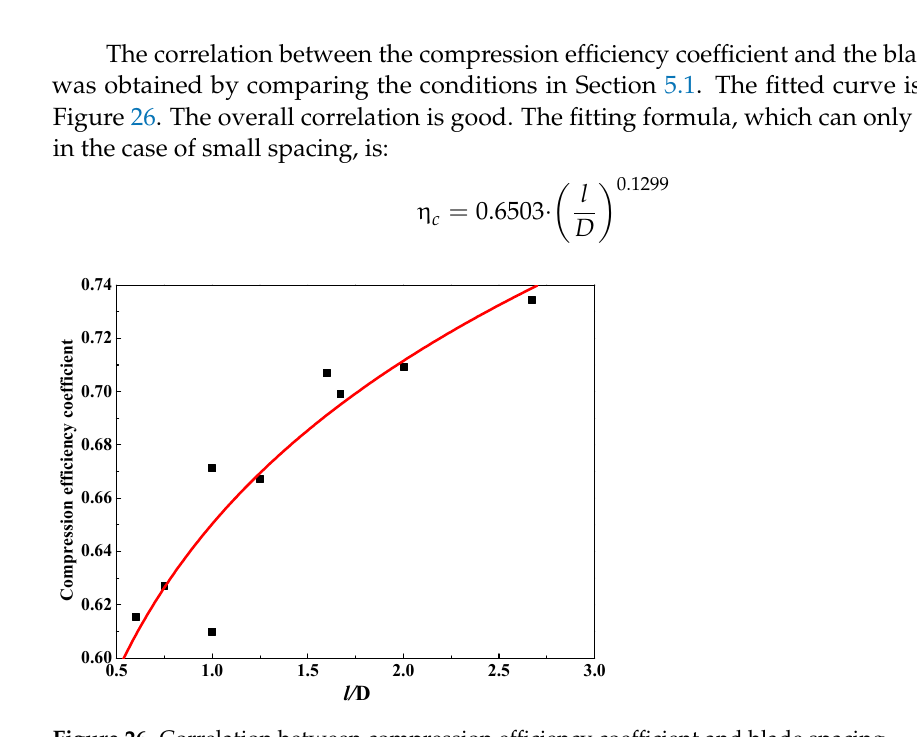
Figure 26. Correlation between compression efficiency coefficient and blade spacing.